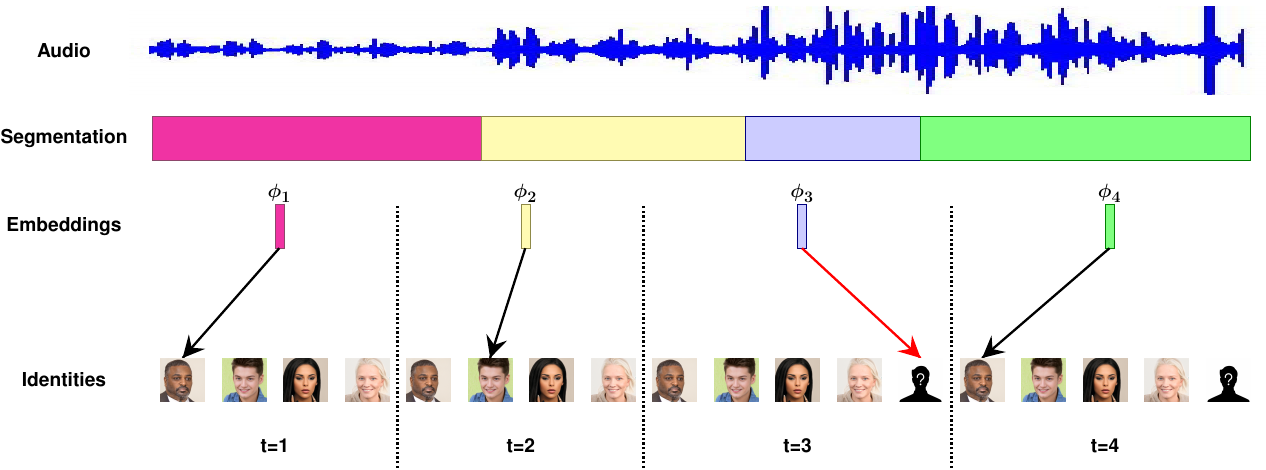
Figure 7. Diagram of the hybrid approach. Embeddings ( φ each time t . Initially, the available clusters are only those for the enrolled speakers. When the embedding is not assigned to an existing cluster (t = 3), it is responsible for an extra cluster for an unknown speaker (red arrow). This new cluster is then available along the posterior assignments.